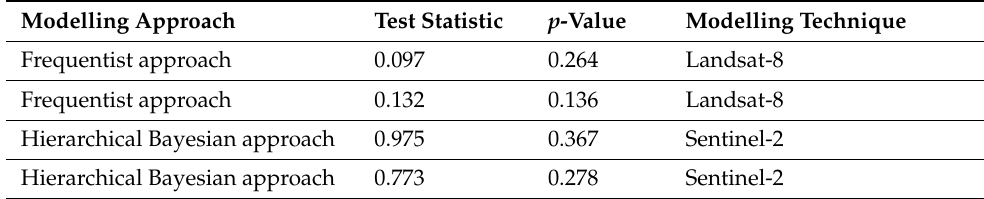
Table 6. Frequentist geostatistical model diagnostics test statistics.